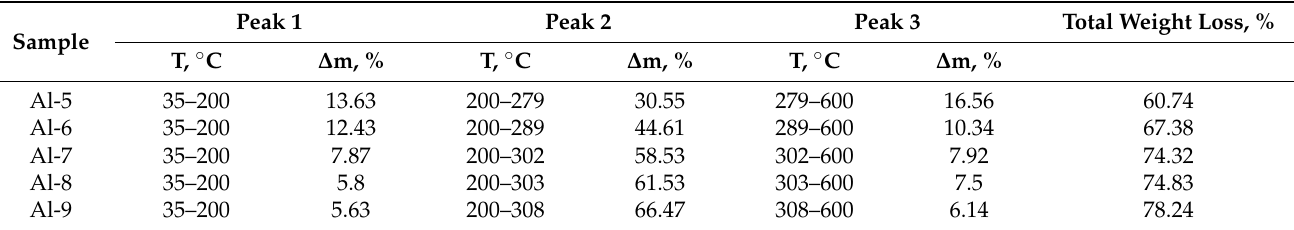
Table 3. Results of thermal